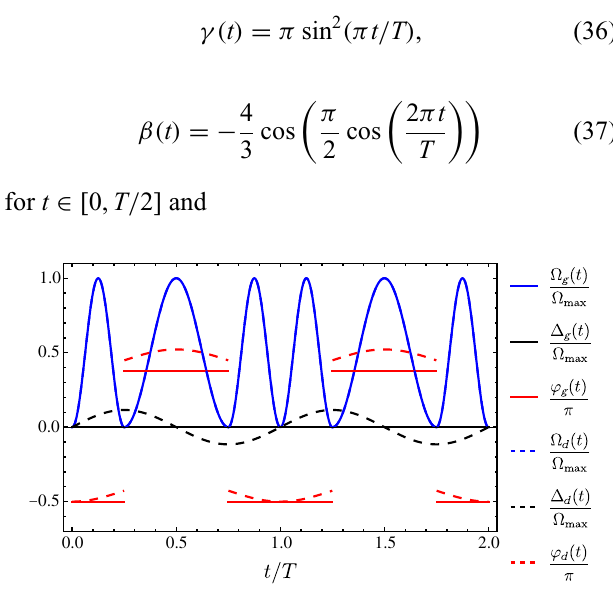
FIG. 3. A plot of the control parameters that generate an X π/ 2 gate. The subscript “ g ” (“ d ”) denotes the control parameters that generate a geometric (dynamical) gate. The values are normal- ized by (cid:11) max , which denotes the maximum value of (cid:11) g ( t ) . Note that (cid:11) g ( t ) = (cid:11) d ( t ) and that (cid:13) d ( t ) is nontrivial.